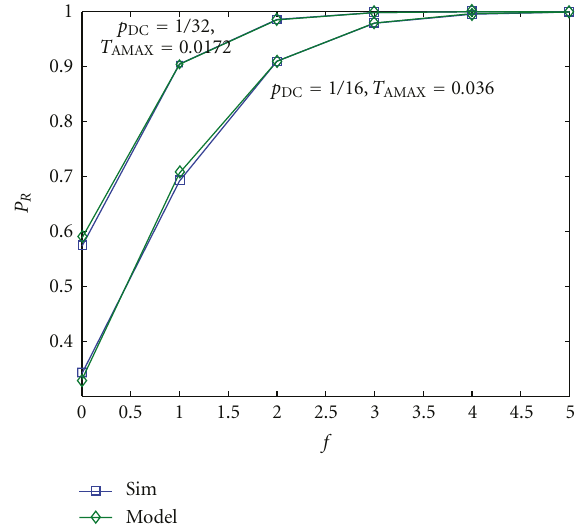
Figure 11: P R versus f when P DC = 1/32 and T A MAX = 17.2 ms, and when P DC = 1/16 and T A MAX = 36ms.